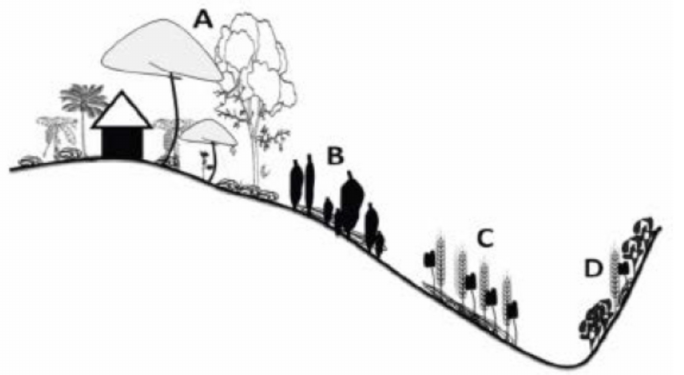
Figure 2. Sketch of spatial distribution of gardens A–D in a typical Haitian farm (reproduced with permission from Jean-Denis et al.